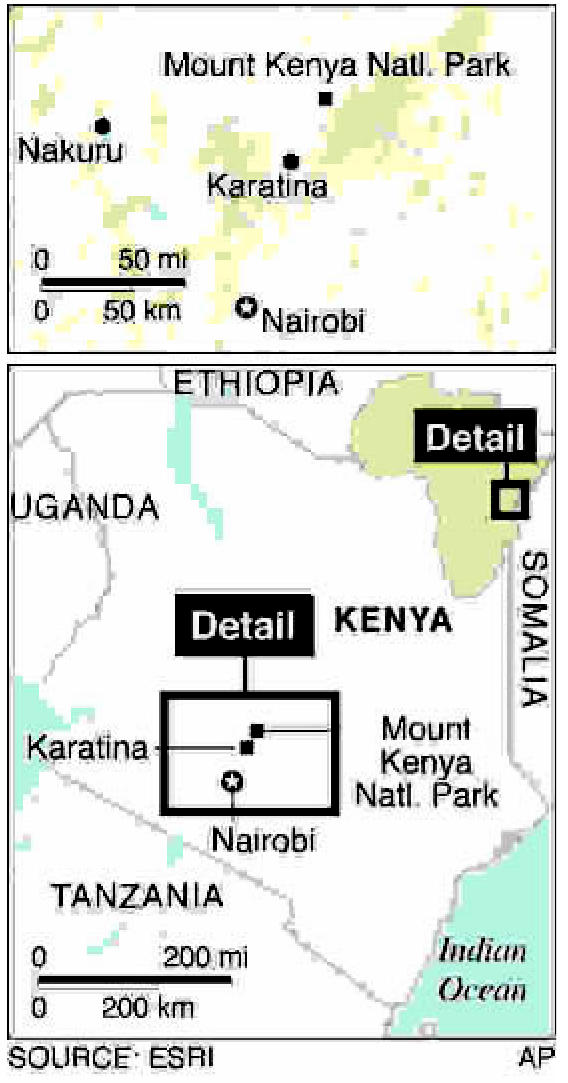
Kenya highlands